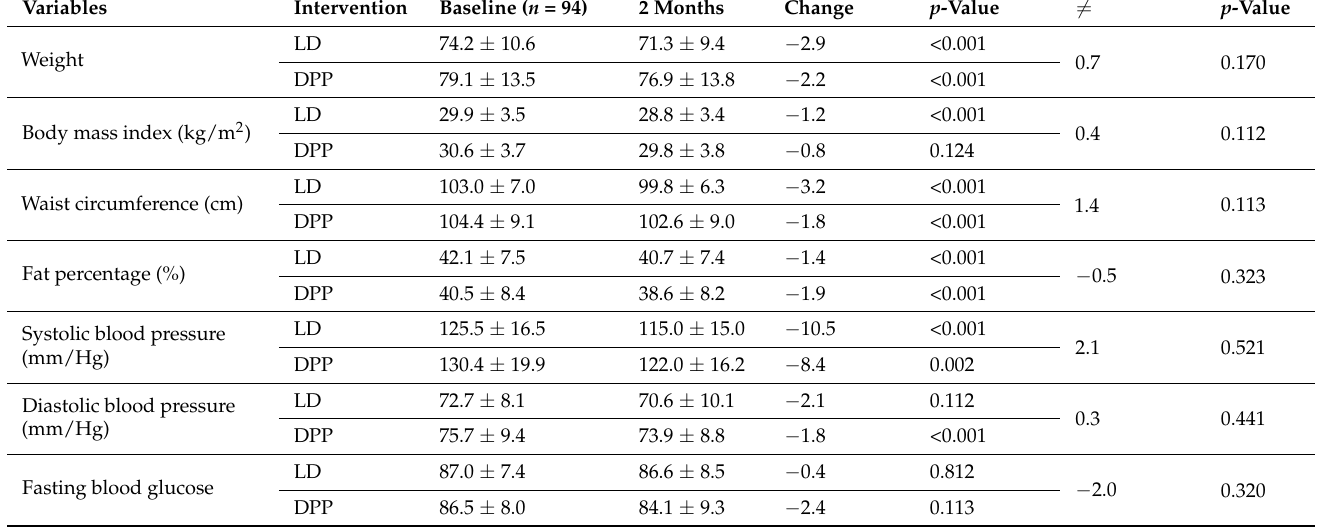
Table 4. Modifiable components at the first phase of the